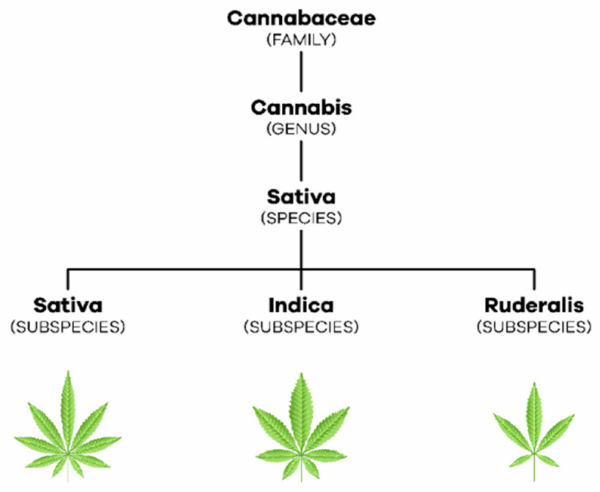
Figure 1. Taxonomic organization of C. sativa